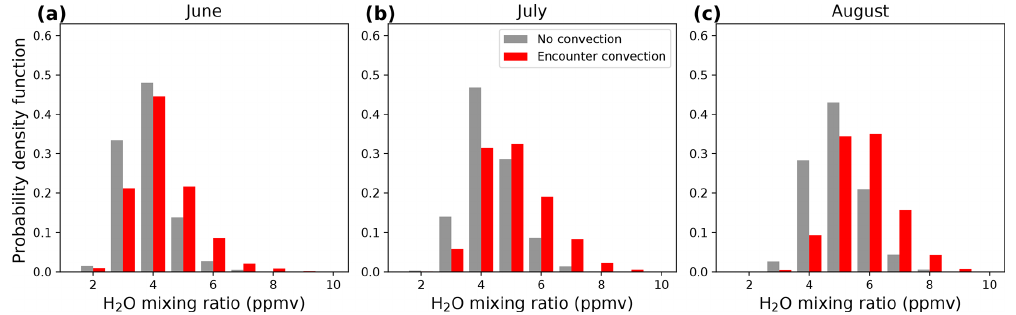
Figure 2. Probability density function of MLS water vapor observations at 100hPa averaged over NA (25–50 ◦ N, 70–130 ◦ W) in (a) June, (b) July, and (c) August 2005–2016. The observations are divided into two groups: (red) those whose back trajectory encounters convection and (grey) those that do